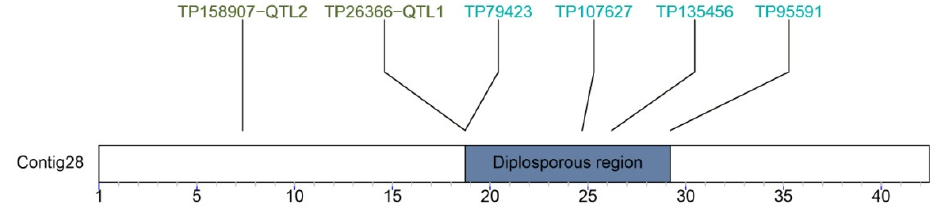
Figure 3. Region linked to apomixis in E. curvula (Victoria cv.) with four linked GBS-SNPs markers (blue label) and two mapped QTLs (green label).